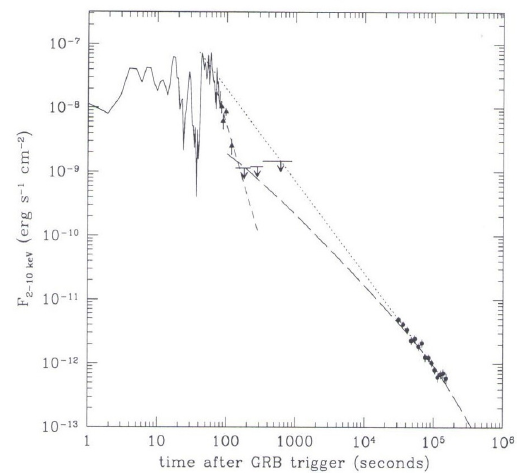
Figure 17. The X-ray light curve of GRB 990510 and its AG, measured with BeppoSAX together with a single power-law fit and a smoothly broken single power-law fit to its X-ray AG